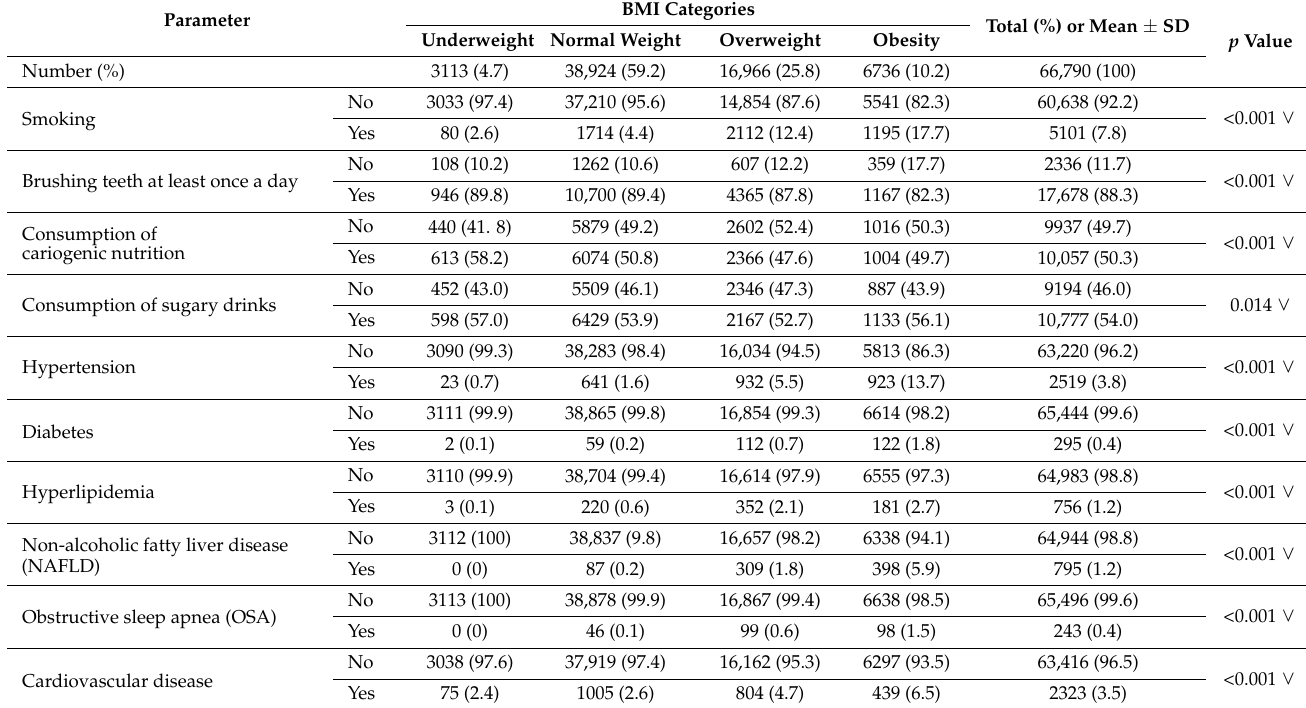
Table 2. Health-related practices and metabolic morbidity of the study population across the four Table 1. Socio - demographics of the study population across the four Body Mass Index (BMI) cate- Body Mass Index (BMI) categories, gories * ANOVA, ˅ Likelihood ratio, SES: Socio-economic status, FSU: Former Soviet Union.